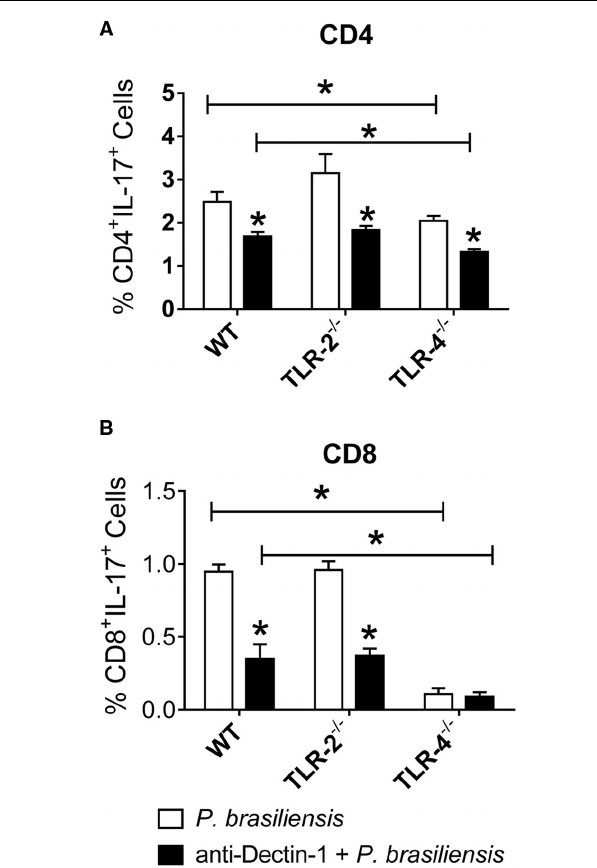
FIGURE 6 | Dectin-1 collaborates with TLR-4 in the development of IL-17 producing cells. BMDCs from WT, TLR-2 (cid:0) / (cid:0) , and TLR-4 (cid:0) / (cid:0) mice were treated or not with anti-Dectin-1 antibody for 30 min and infected with viable P. brasiliensis yeasts for 2 h. Splenic lymphocytes from uninfected WT, TLR-2 (cid:0) / (cid:0) , and TLR-4 (cid:0) / (cid:0) mice were co-cultivated with anti-Dectin-1 treated or untreated DCs. After 5 days, the cells were adjusted to 1 (cid:2) 10 6 and re-stimulated with PMA/ionomycin for 6 h, labeled with specific anti-CD4 (A) and CD8 (B) antibodies and subjected to intracellular staining for IL-17. The cells were analyzed by flow cytometry, and the lymphocyte population gated by FSC/SSC analysis. The results are expressed as frequency of positive cells. Data are means (cid:6) SD of five wells per group from three independent experiments (* P < 0.05).